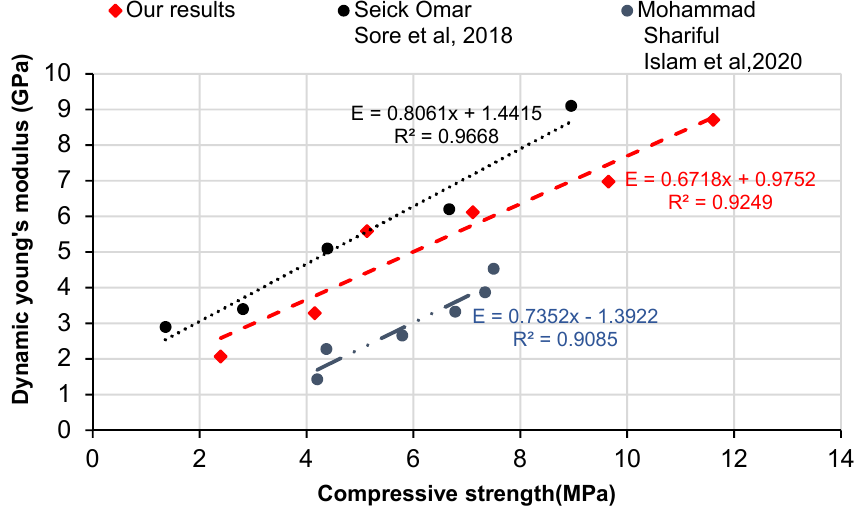
Figure 9. Correlation between Young’s modulus and dry compressive Figure 6. Correlation between Young’s modulus and dry compressive strength.